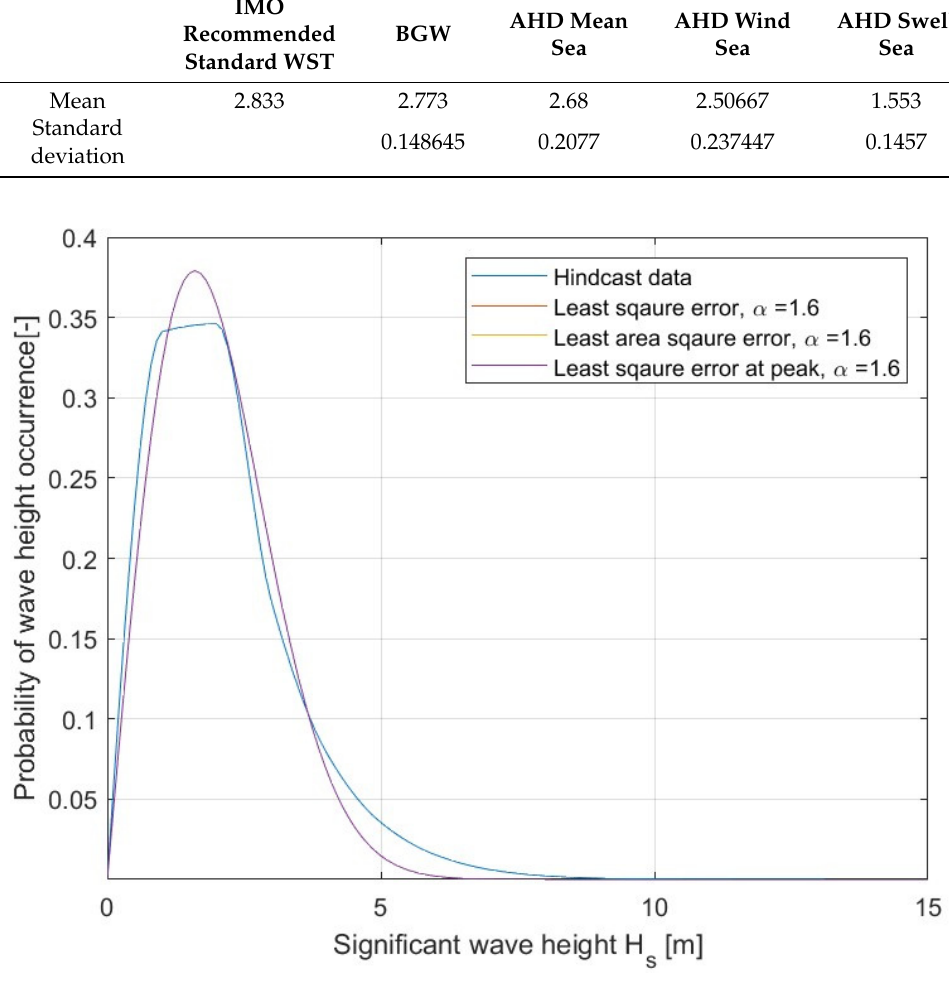
Figure 9. Plots of WST swell sea pdf (sea area S—full year). Table 6. Rayleigh shape parameter for AHD data (mean sea).